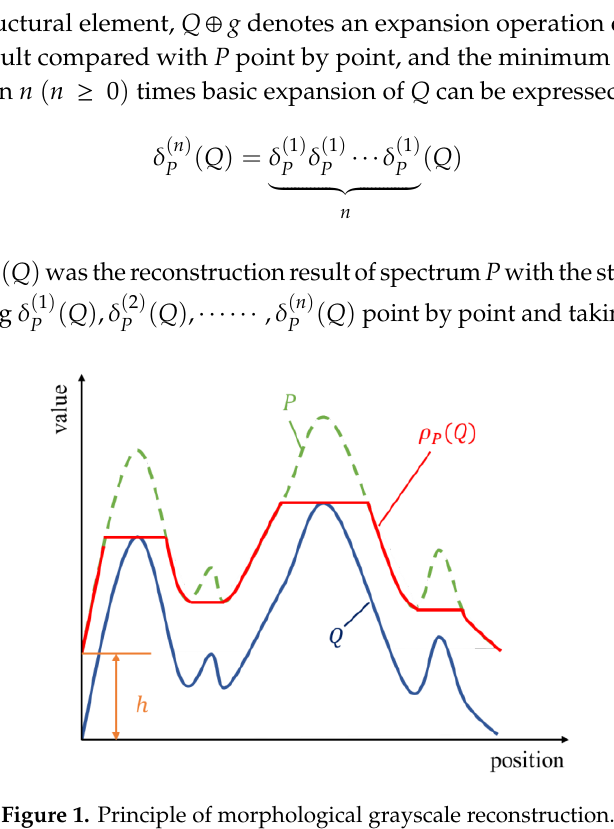
Figure 1. Principle of morphological grayscale reconstruction.